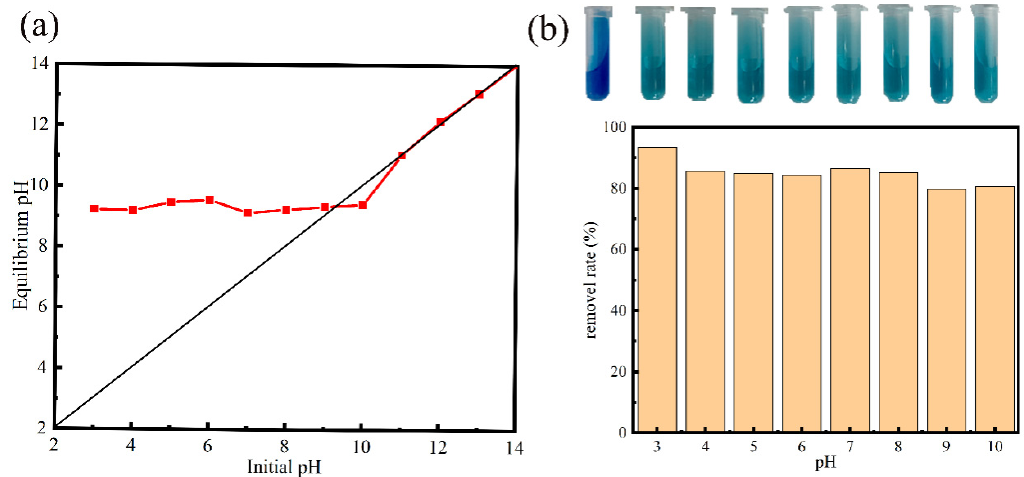
Figure 7. ( a ) pH drift method to determine the pH of the point of zero charge (pHpzc) for the Ca-MOF/ABS/TPU 3D skeleton. ( b ) Effect of pH on the MB adsorption by the Ca-MOF/ABS/TPU 3D skeleton (the initial MB concentration was 100 mg/L).